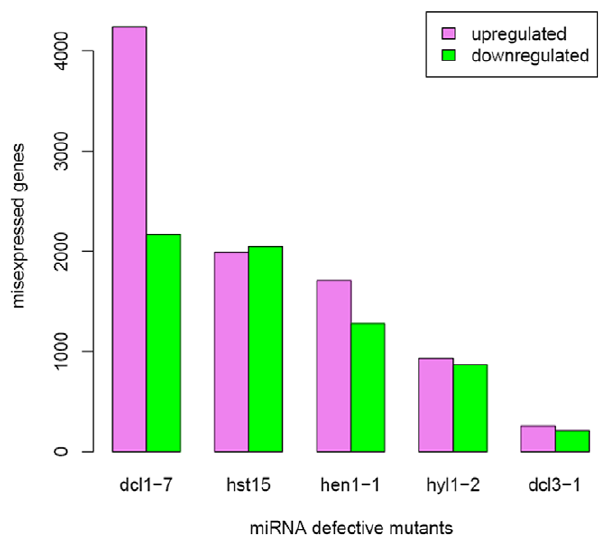
Figure 1. Numbers of transcripts that were up-regulated or down-regulated in mutant lines compared to wild-type lines. Genes were classified as up-regulated or down-regulated if their transcript abundance increased or decreased, respectively, and the changes were statistically significant (FDR=0.05).